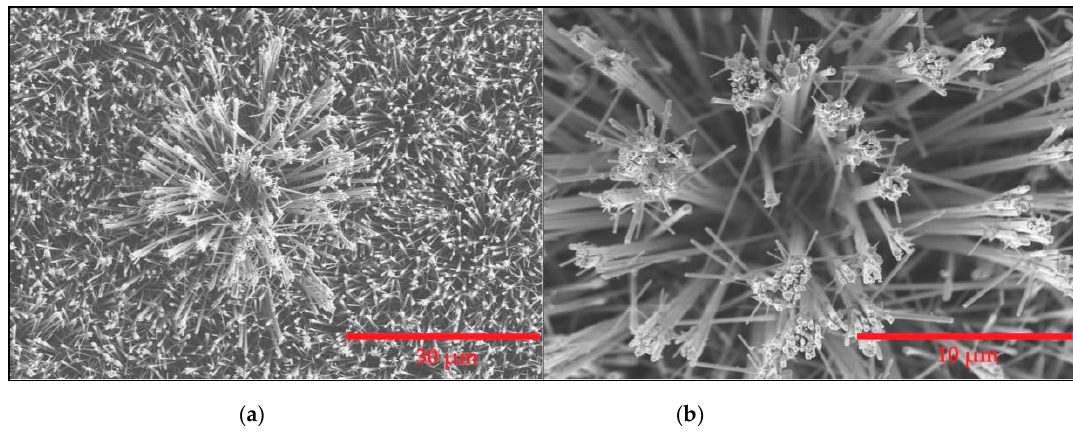
Figure 1. Left panel: ( a ) WO 3 nanowires layer grown employing AACVD process. Rigth panel: ( b ) close look to the tip of the nanowires were the iridium nanoparticles had been attached.